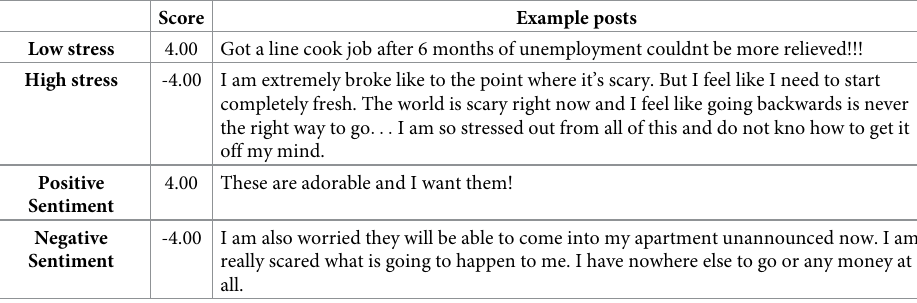
Table 1. Example of posts displaying extremes of stress and